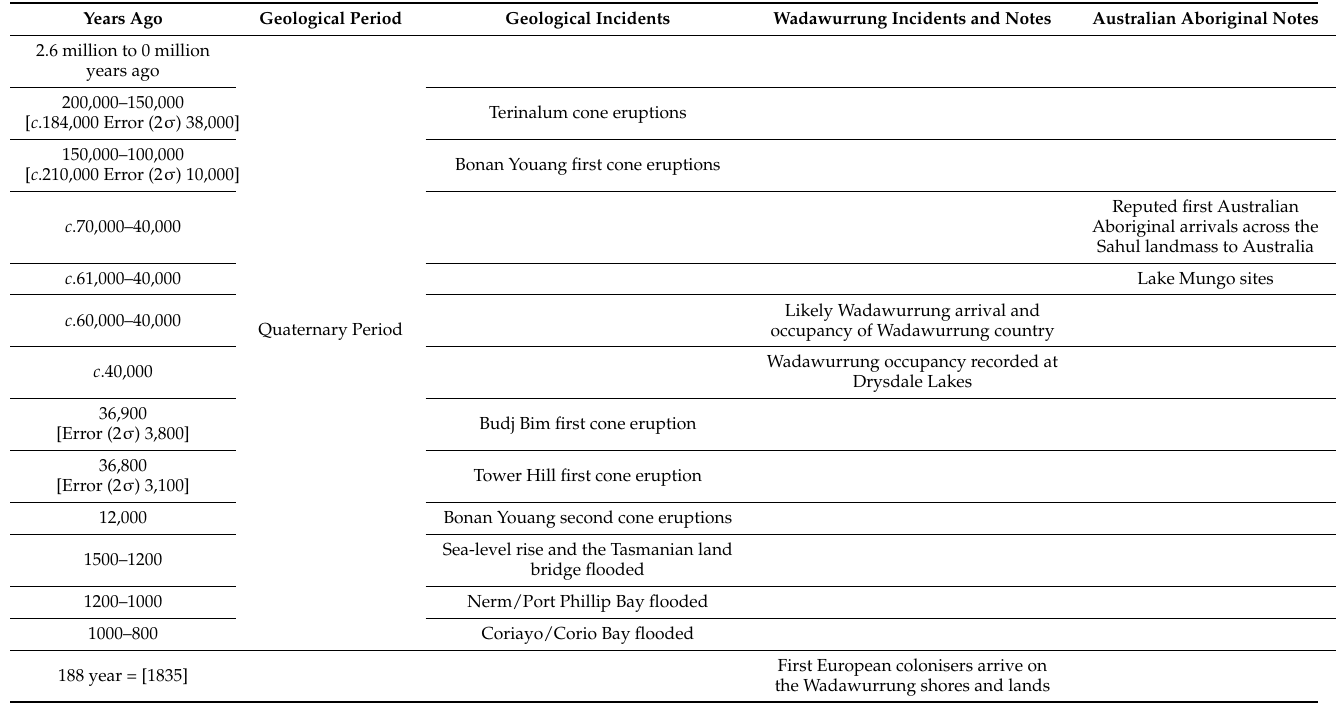
Table 1. Geological and ethnographic